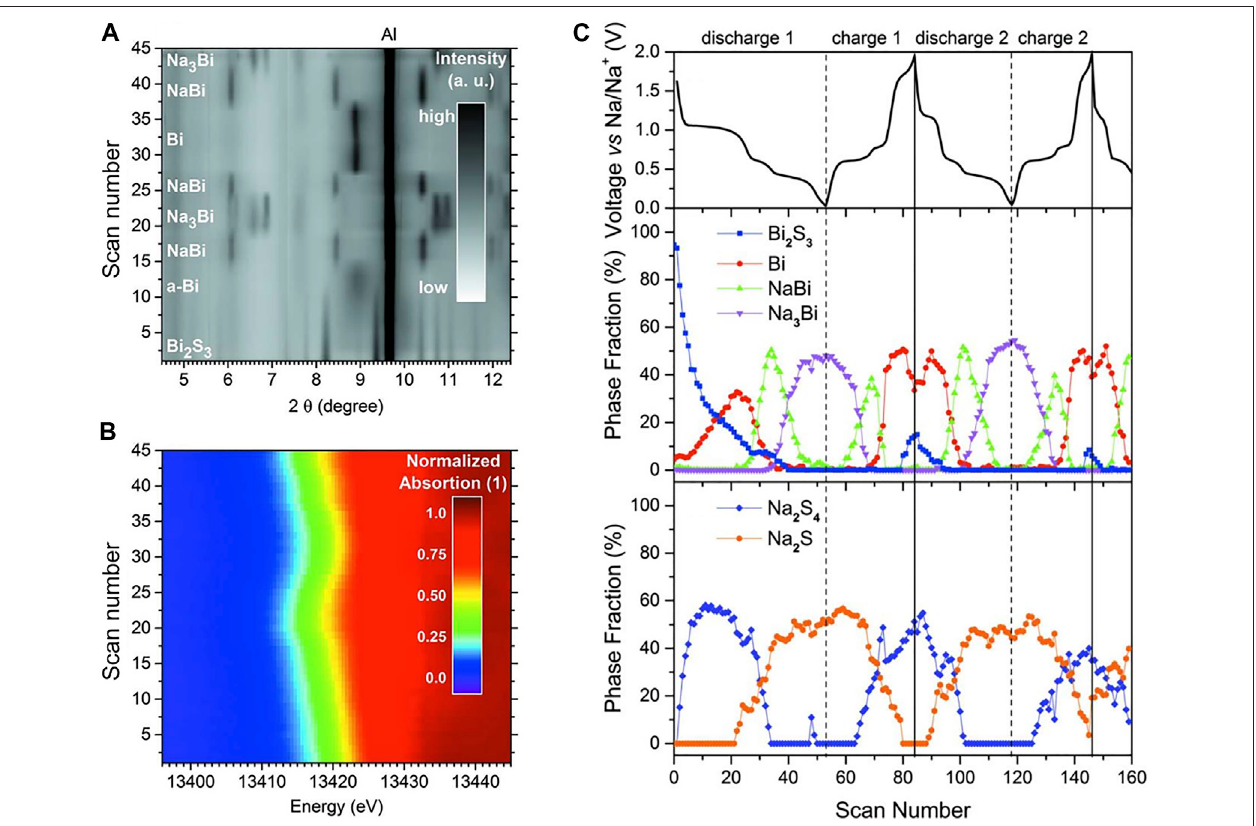
FIGURE 2 | A combined operando (A) XRD and (B) XAS measurement showing (C) the different phase fractions of the phases formed during the fi rst two (de) sodiation cycles of Bi 2 S 3 in half cell vs . Na/Na + . Adapted with permission from the International Union of Crystallography (Sottmann et al.,